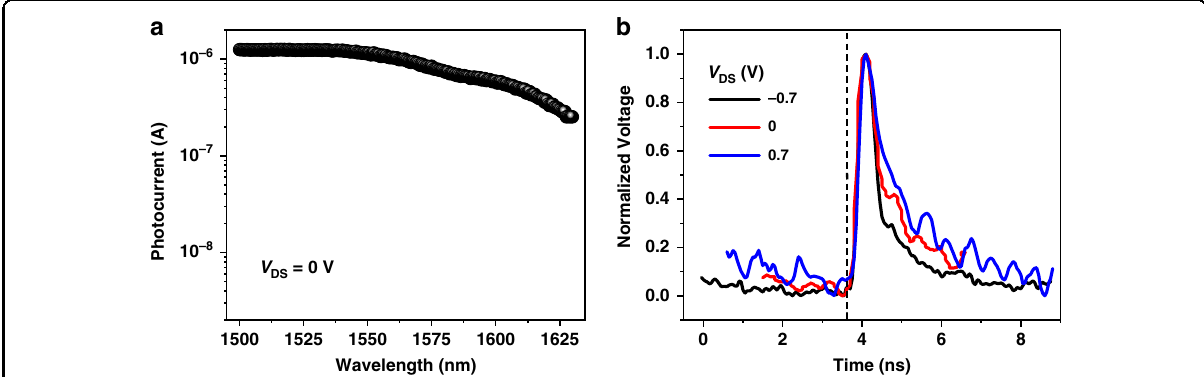
Fig. 3 Steady and dynamic photoresponses of the waveguide-integrated BP/MoTe 2 PN heterojunction photodetector. a Photocurrents measured under the optical illumination at the wavelengths ranging from 1500 to 1630 nm. b Impulse response of the device at zero, positive and negative biases. The vertical dashed line indicates the time point at which the picosecond laser pulse